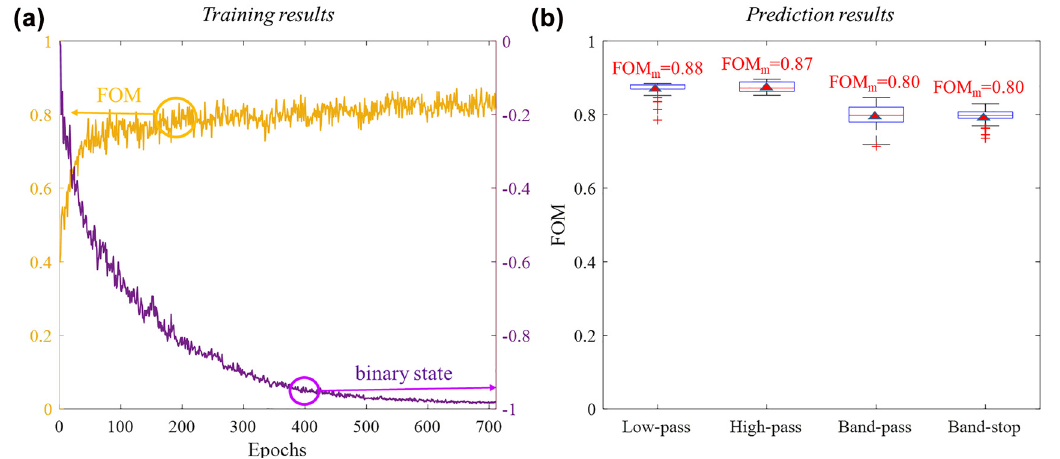
Figure 5: Multi-task optimization results of wavelength filters. (a) Mean FOM (yellow curve) and mean binary state (purple curve) of randomly generated optical targets at each training epoch. (b) Boxplot of the FOMs of predicted devices by the trained DNN for randomly generated optical